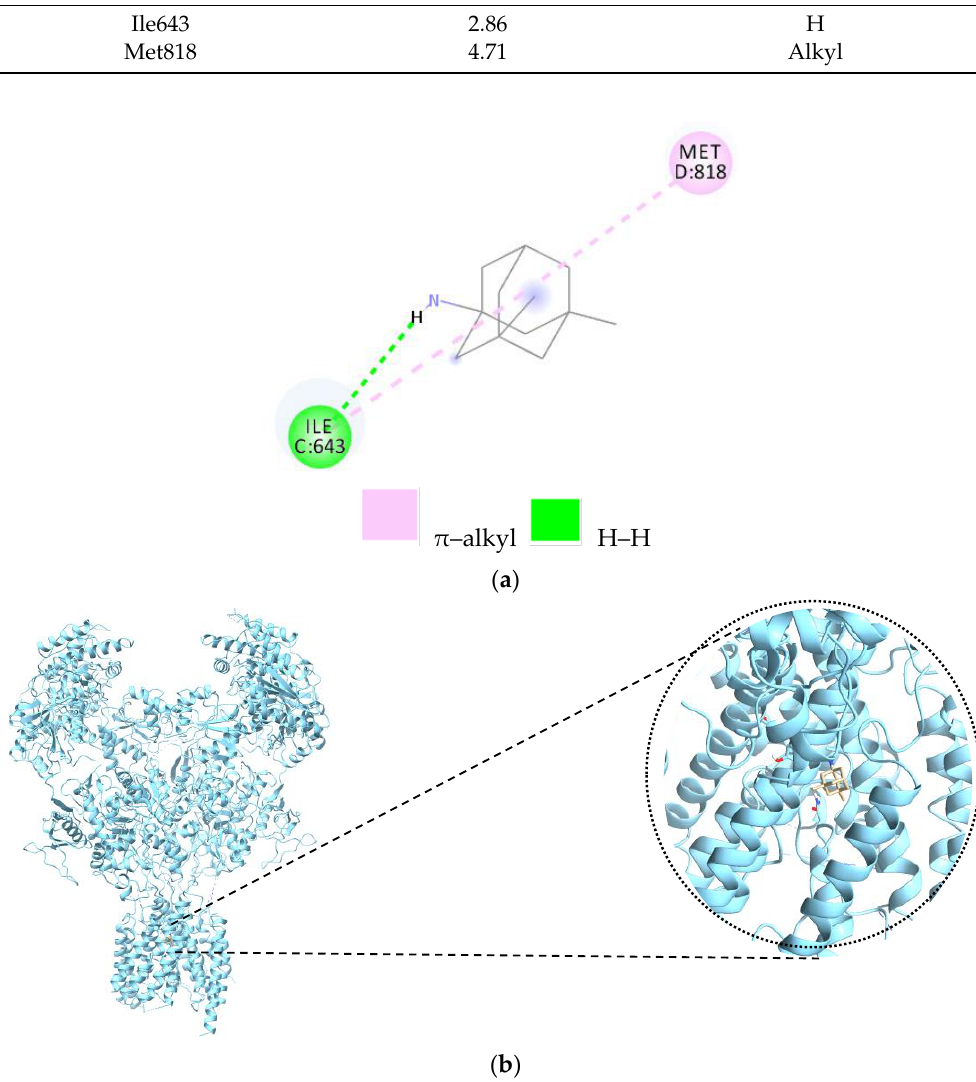
Figure 5. 2D and 3D diagrams representing the link between memantine and NMDA; ( a ) 2D representation of the memantine- NMDA complex; ( b ) 3D representation of the Memantine—NMDA complex. Legend: ILE—isoleucine; MET—methionine; the letters C and D represent the chain, and the number represents the numbering of the amino acid.